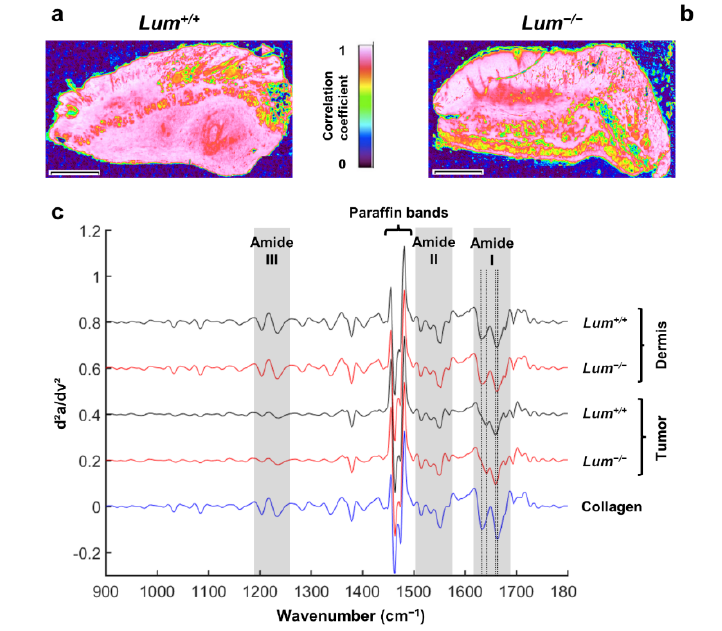
Figure 6. Correlation maps using type I collagen reference spectrum. ( a , b ) Type I collagen spectral correlation images of Lum +/+ ( a ) and Lum − / − ( b ) tissue sections (scale bar 500 µm). Original images were each correlated with a pure type I collagen spectrum. Provided scale indicates the degree of correlation from 0 (black, not correlated) to 1 (white, completely correlated). ( c ) Comparison between type I collagen second derivative spectrum (blue line) with second derivative spectra taken randomly from the dermis and tumors of Lum +/+ (black lines) and Lum − / − (red lines) mice skin tissues. Second derivative spectra are offset for clarity. The corresponding collagen-characteristic bands of Amide I, II, and III are highlighted. Dotted lines in the Amide I band indicate 1633, 1641, 1658, and 1662 cm − 1 wavenumbers, respectively.